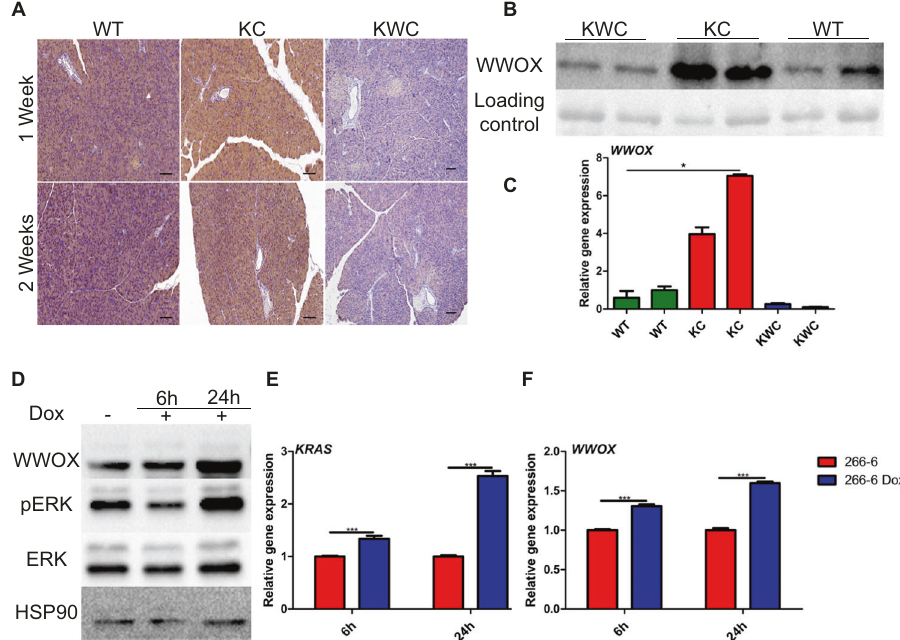
Fig. 2 Induction of WWOX expression upon KRAS activation both in vitro and in vivo. A Representative WWOX immunostaining at normal sites of WT, KC, and KWC mice 1- and 2-week post-tamoxifen injection. B Representative immunoblotting of WWOX of KWC ( n = 3), KC ( n = 3), and WT ( n = 3) mice 1-month post-tamoxifen injection. C RT-PCR of Wwox in sorted acinar cells of WT, KC, and KWC mice 1-month post- tamoxifen injection. D Immunoblotting of ERK, pERK, and WWOX in 266-6 cells activated/nonactivated for 6 and 24 h. E RT-PCR of Kras in 266-6 cells activated/ nonactivated for 6 h, and 24 h. F RT-PCR of Wwox in 266-6 cells activated/ nonactivated for 6 and 24 h. * P < 0.05, ** P < 0.001. Two-tail unpaired t -test. Quanti fi cation graphs are presenting the means ±